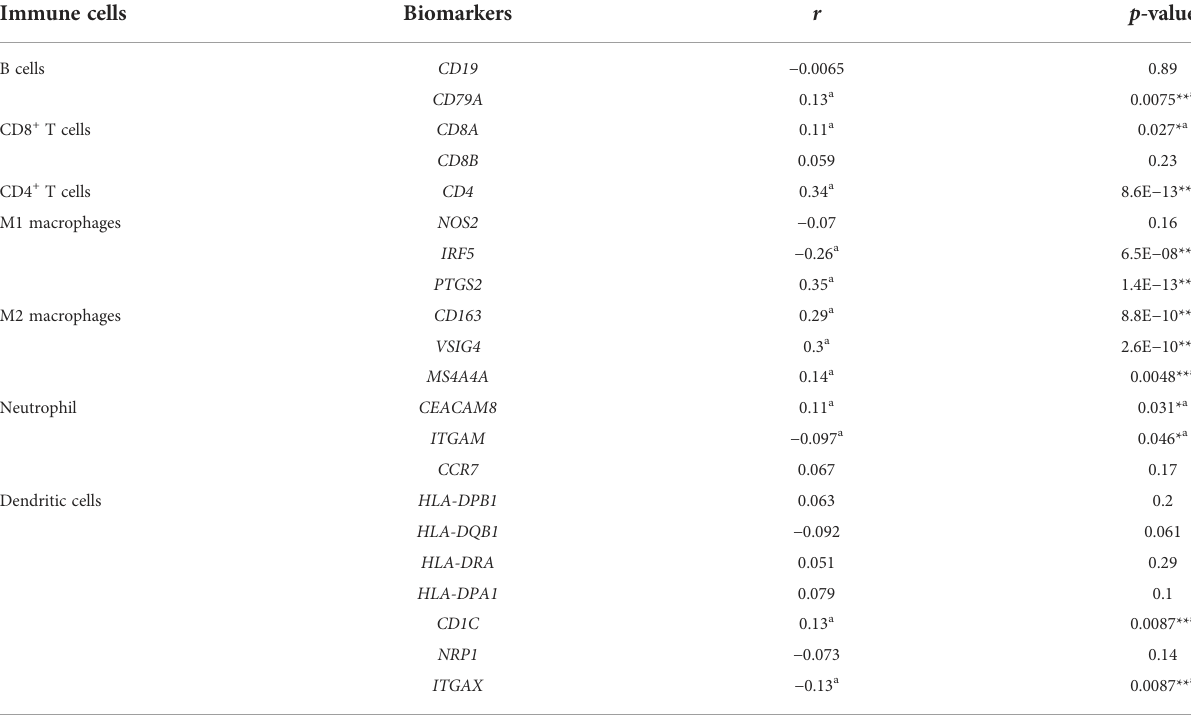
TABLE 1 Correlation analysis between FCN2 and the biomarkers of immune cells in hepatocellular carcinoma (HCC) determined using the GEPIA database (Spearman ’ s correlation coef fi cient). Immune